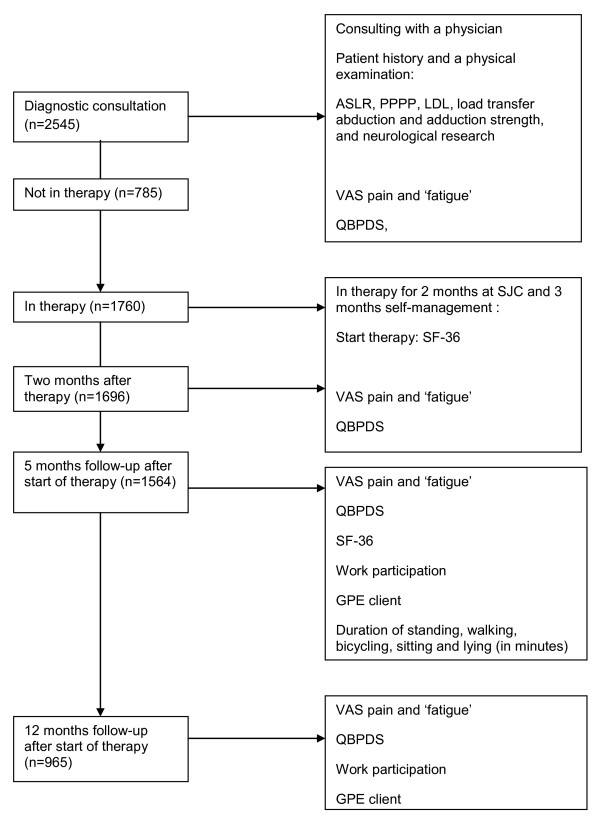
Study design. ASLR = Active Straight Leg Raise test; PPPP = Posterior Pelvic Pain Provocation test; LDL = longum dorsal sacroiliac ligament; VAS = Visual Analogue Scale; QBPDS = Quebec Back Pain Disability Scale; SF-36 = Short Form; TSK = Tampa Scale Kinesiophobia.